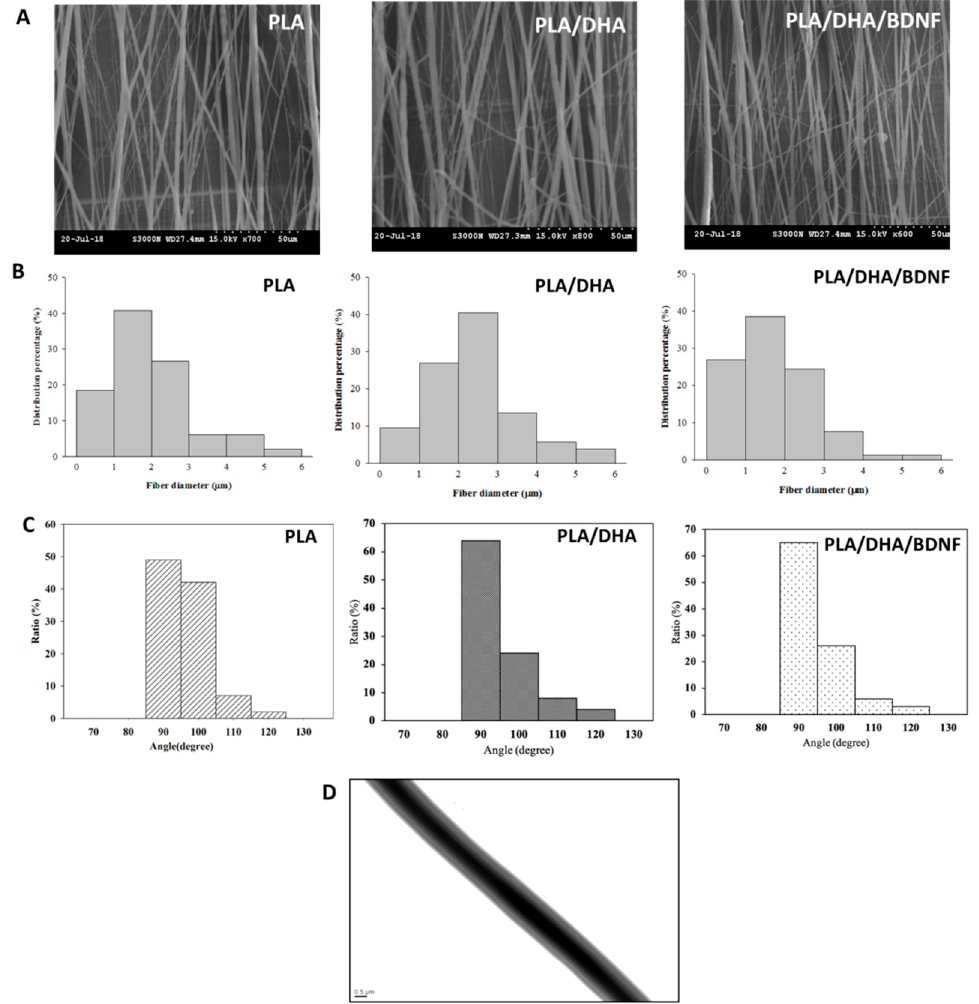
Figure 2. The scanning electron microscopy images ( A ), bar = 50 μ m, the fiber diameter distribution ( B ), and the fiber angle distribution ( C ) of PLA, PLA/DHA, and PLA/DHA/BDNF core–shell fibrous membranes (CSFMs). The transmission electron microscopy (TEM) ( D ) bar = 0.5 μ m, image of PLA/DHA/BDNF CSFM.